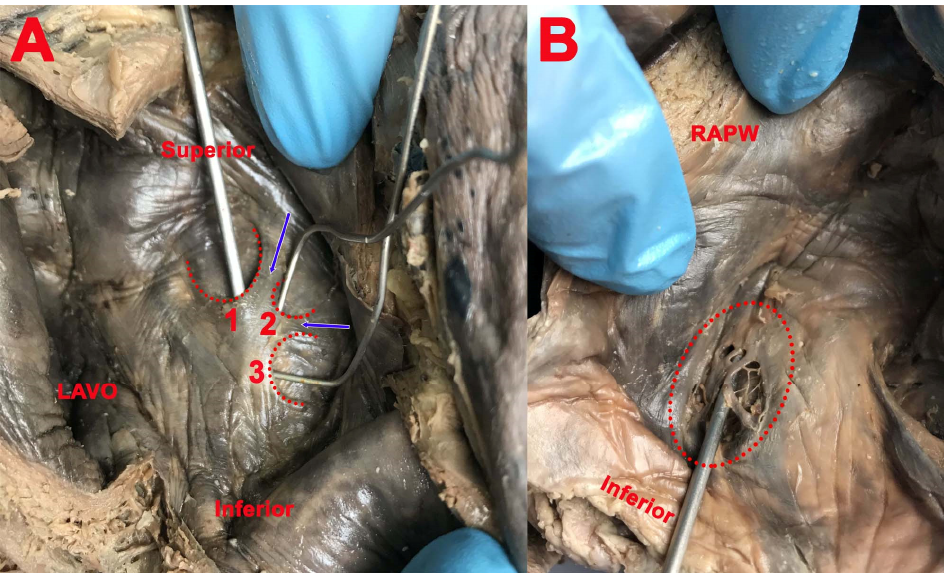
Figure 5. ( A ): 1, 2, and 3—triple SP, separated by two fibro-muscular bundles (blue arrows); LAVO — left atrioventricular orifice. ( B ): FO (red interrupted line) covered by net-like structure; RAPW — right atrial posterior wall.